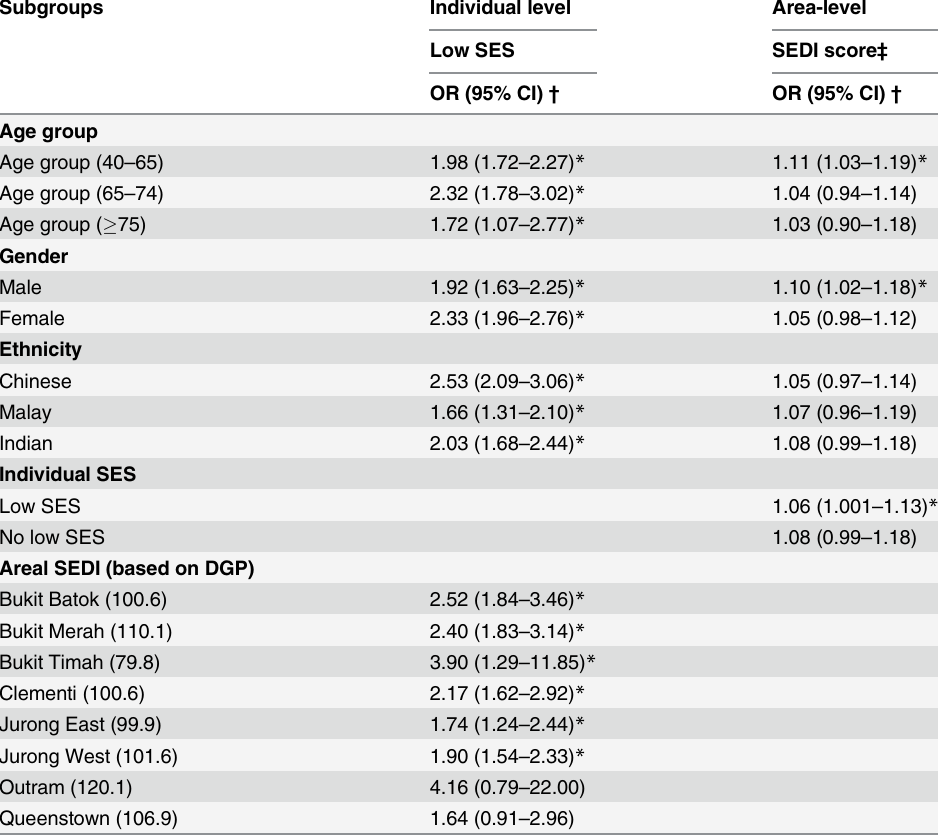
Table 4. Multi-level analysis of socio-economic status with presence of any visual impairment strati- fied by